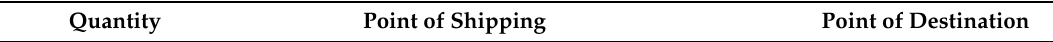
Table 2. Conditions of